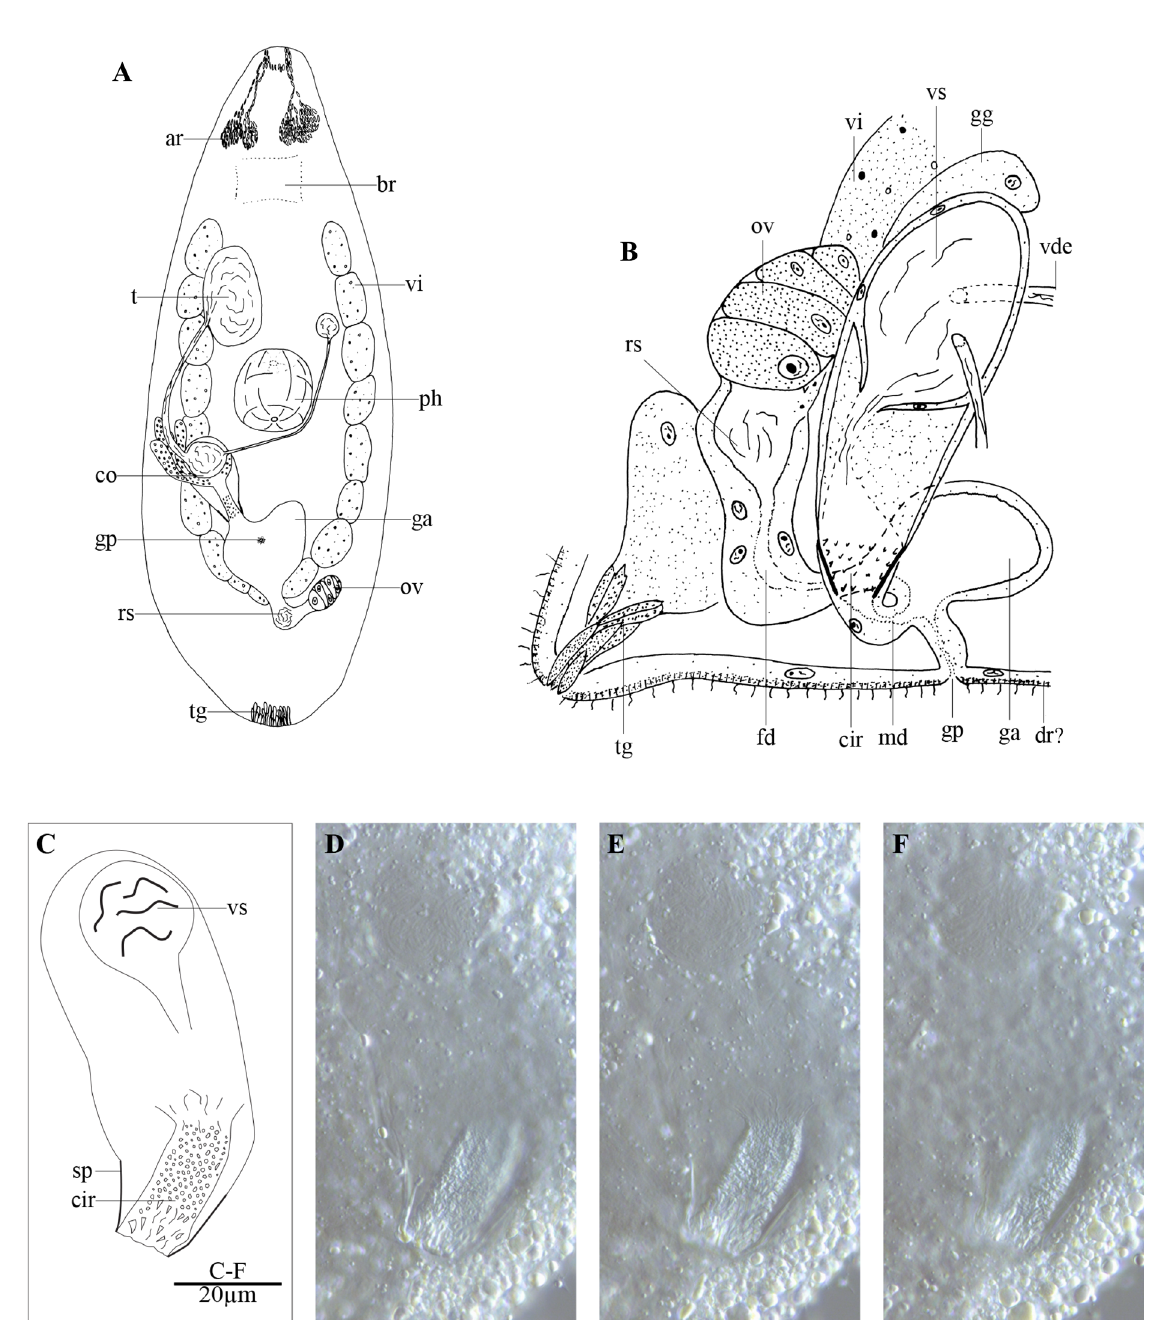
Fig. 2. Faunulus nielsi Houben, Proesmans & Artois gen. et sp. nov. A . Internal organisation of a live specimen, B . Reconstruction of reproductive organs based on sagittal sections of the holotype (KV.686). C–F . Male copulatory organ of the paratype (paratype no.